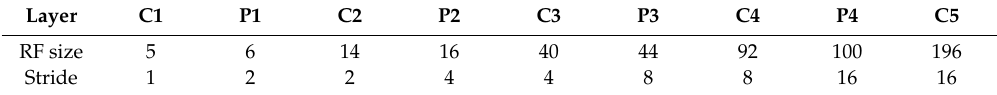
Table 1. Receptive field and stride size of each layer. RF, receptive field; C, convolution; P,